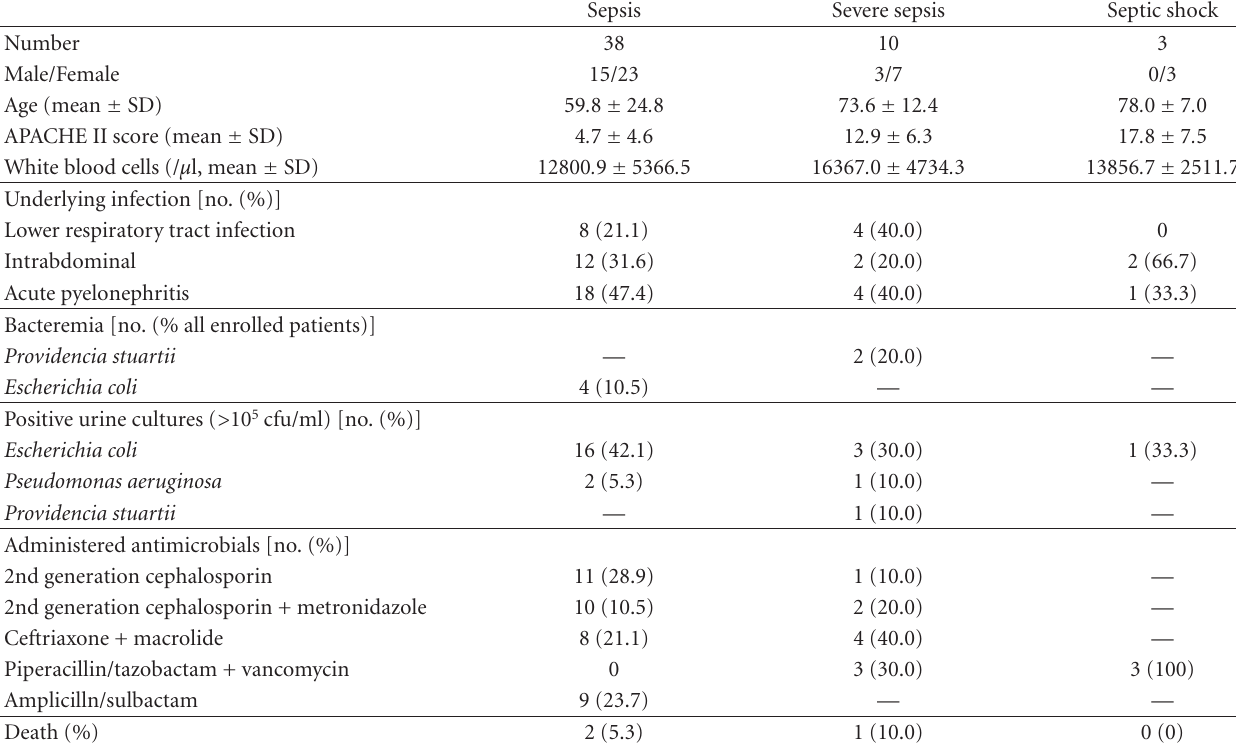
Table 1: Demographic characteristics of 51 patients with septic syndrome enrolled in the